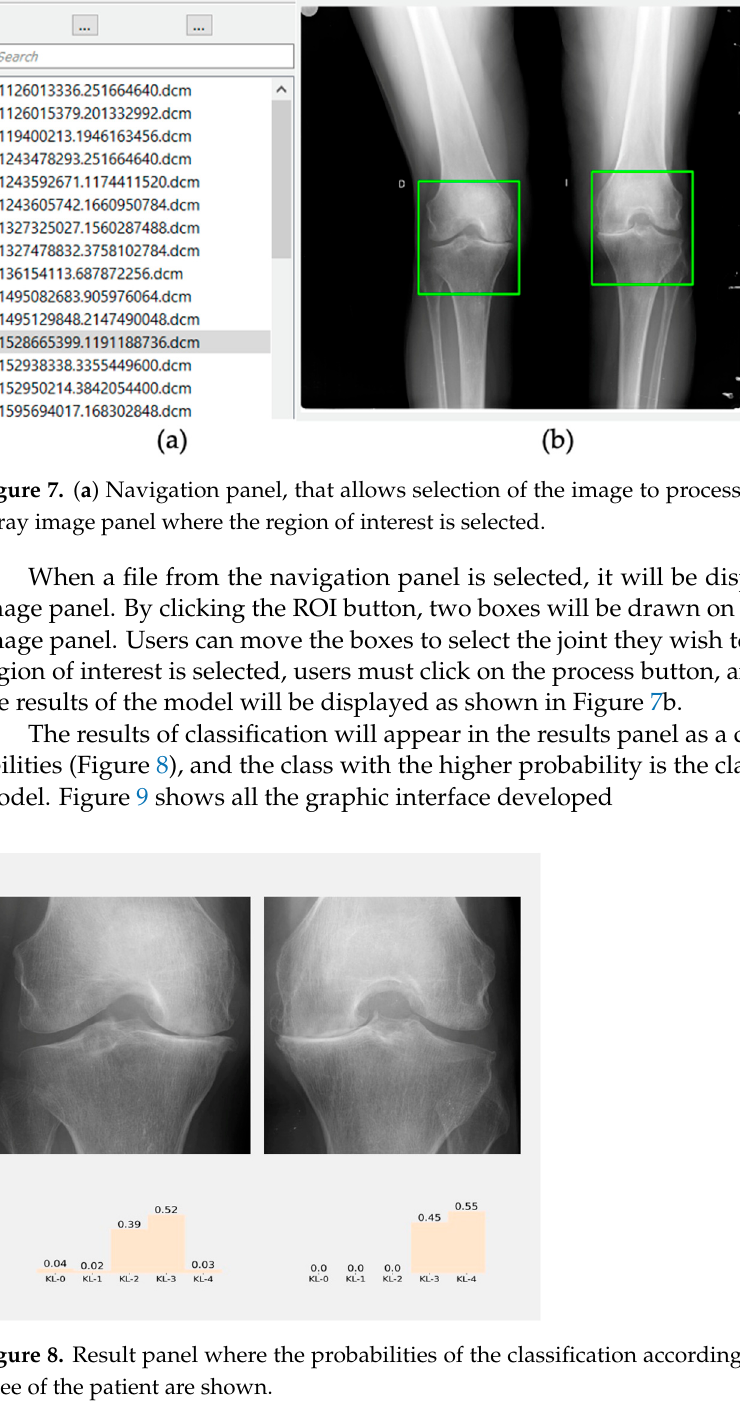
Figure 8. Result panel where the probabilities of the classification according to KL grades in each knee of the patient are shown.